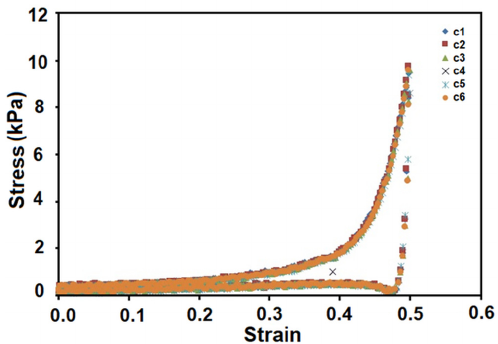
Figure 5. Cyclic compressive properties of sample CP7 (Entry 2, Table 1).